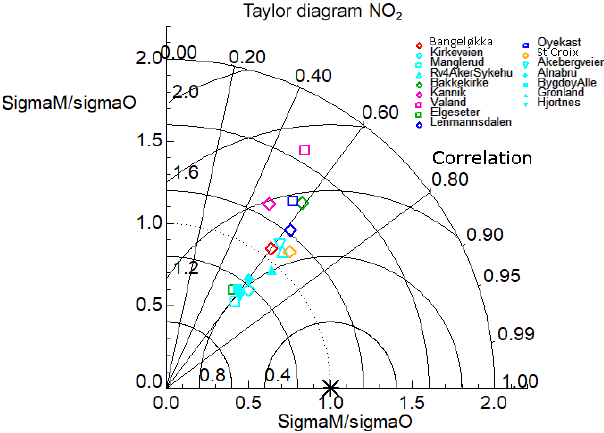
Figure 8. A Taylor diagram calculated using the annual hourly time series of NO 2 concentrations for all 16 in situ stations used for the model evaluation across all six domains. The symbols are colour- coded according to each model domain: Drammen is red, Oslo is cyan, Trondheim is green, Stavanger is pink, Grenland is dark blue, and Nedre Glomma is orange. The x and y axes both represent the ratio of the model standard deviation to the observed standard devi- ation in NO 2 concentrations for a particular station such that points can be plotted on concentric circles centred on the x and y origin. The correlation is plotted according to the azimuthal angle from the origin represented as a series of straight lines emanating from the x and y origin. Lastly, the RMSE (µgm − 3 ) is also represented for each station according to their linear distance from 1.0 on the x axis. Table 8. Mean statistics presented in the Taylor diagram for all 16 observation stations for the full year and the winter, autumn, and summer seasons. σM/σO is the ratio of the model and observed standard deviation in NO 2 concentrations, R is the Pearson corre- lation coefficient, RMSE is the root mean squared error (µgm − 3 ), and IOA is the index of agreement. These statistical metrics are ex- plained in further detail in Appendix